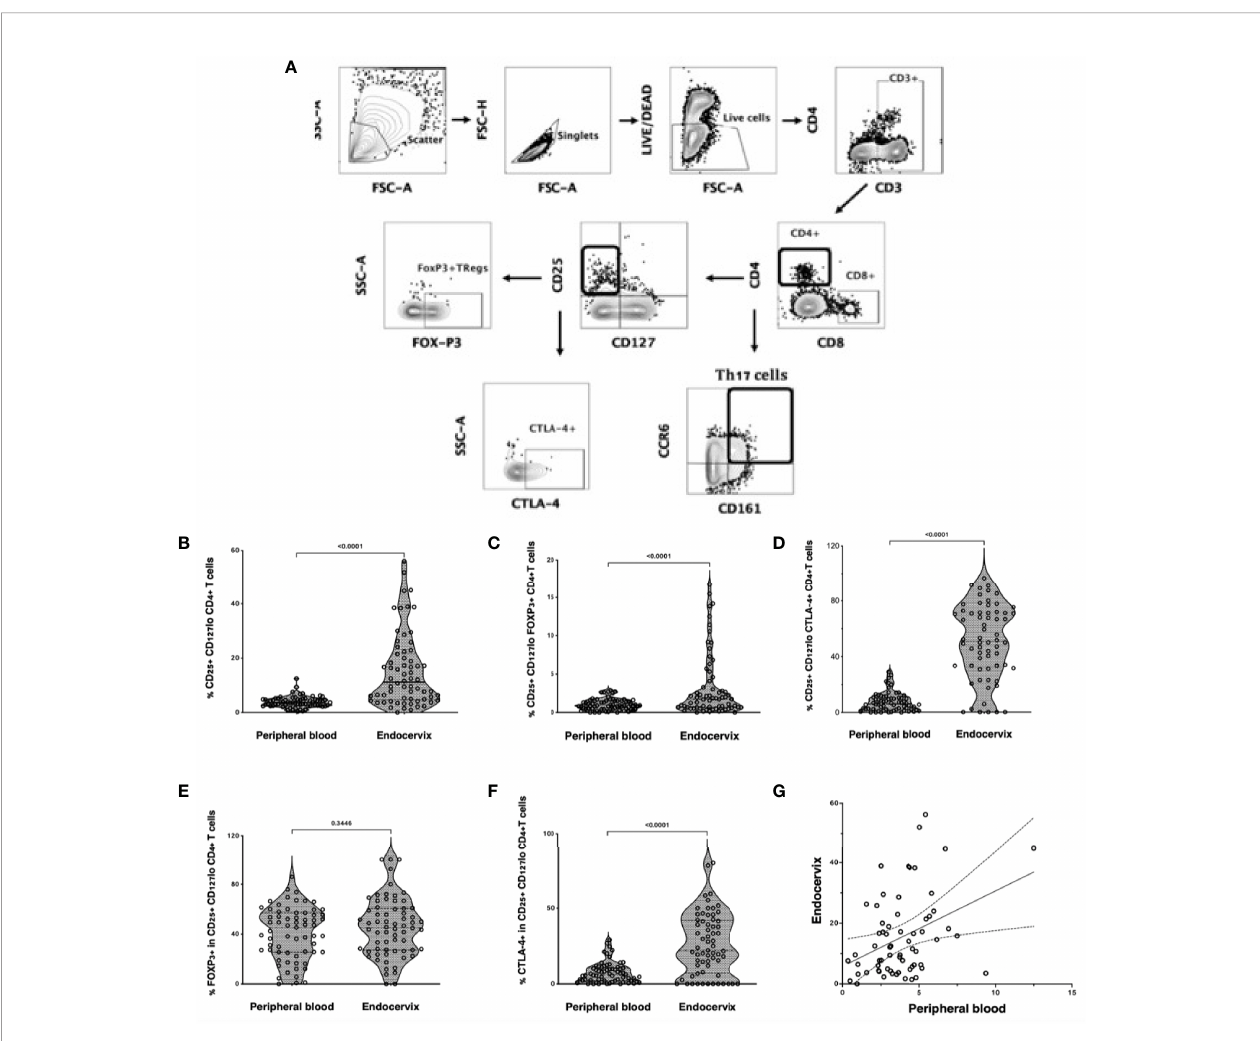
FIGURE 1 | Treg and Th17 phenotyping in blood and endocervix. (A) Representative fl ow cytometry plots showing the gating strategy used to de fi ne Tregs as CD4+ T cells expressing CD25 and low CD127. CD25+CD127lo cells were then gated for FOXP3 or CTLA-4 expression. Th17 cells were de fi ned by the co-expression of CD161 and CCR6. (B) Proportions of CD25+CD127lo CD4+ T cells in the blood and cervix. (C) Proportions of CD25+CD127lo FOXP3+ CD4+ T cells. (D) Proportions of CD25+ CD127lo CTLA-4+ CD4+ T cells, (E) %FOXP3 expression within CD25hi CD127 lo CD4+ T cells, (F) %CTLA4 expression within CD25hi CD127 lo CD4+ T cells, (G) CD25 +CD127lo Tregs in the endocervix correlated with peripheral blood